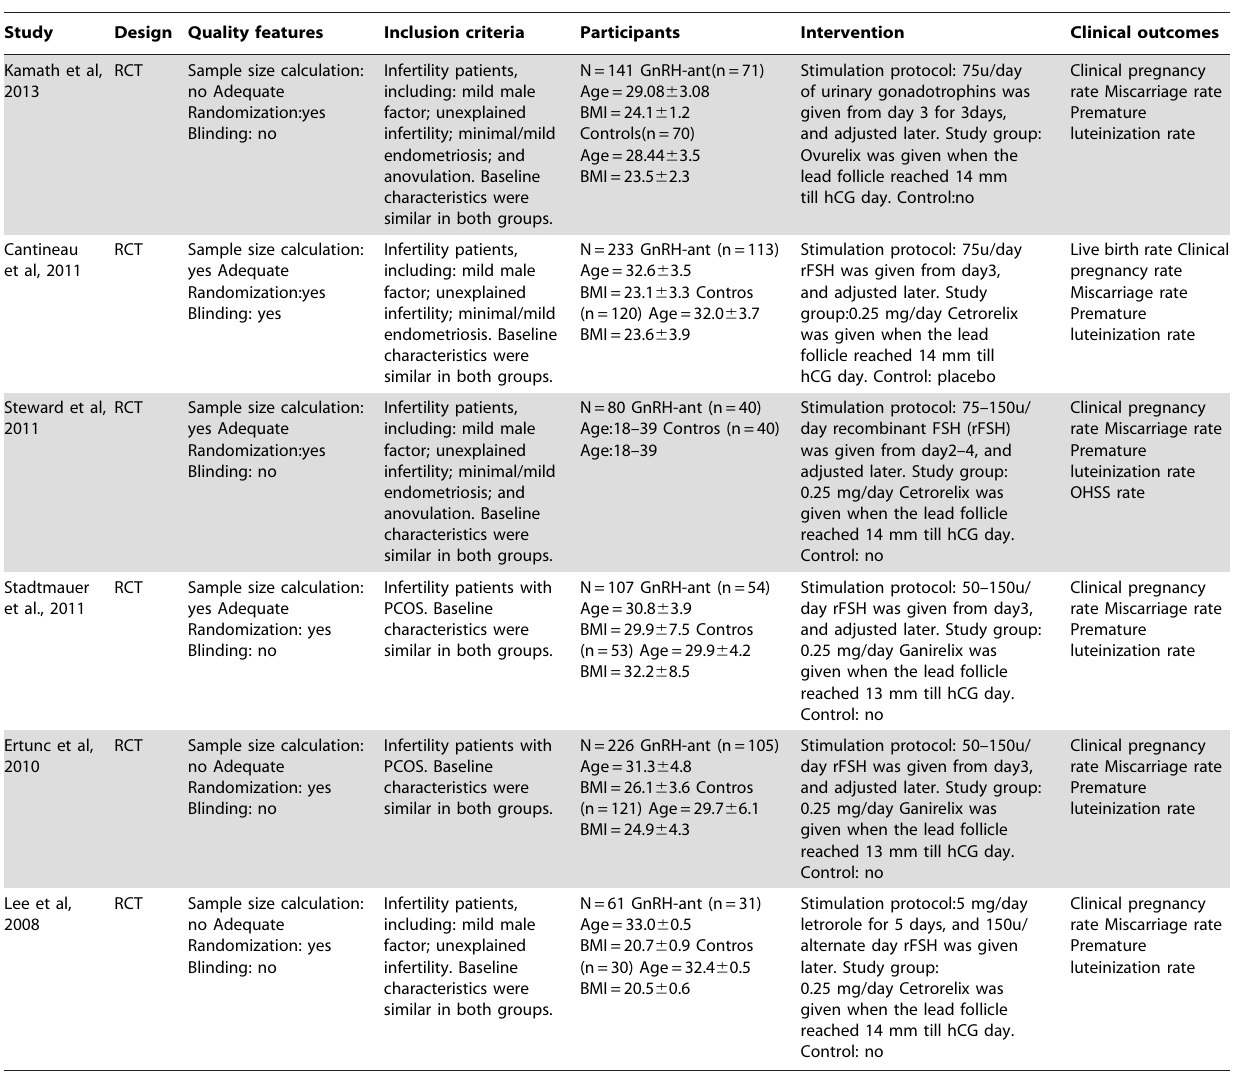
Table 1. Summary of study characteristics and clinical